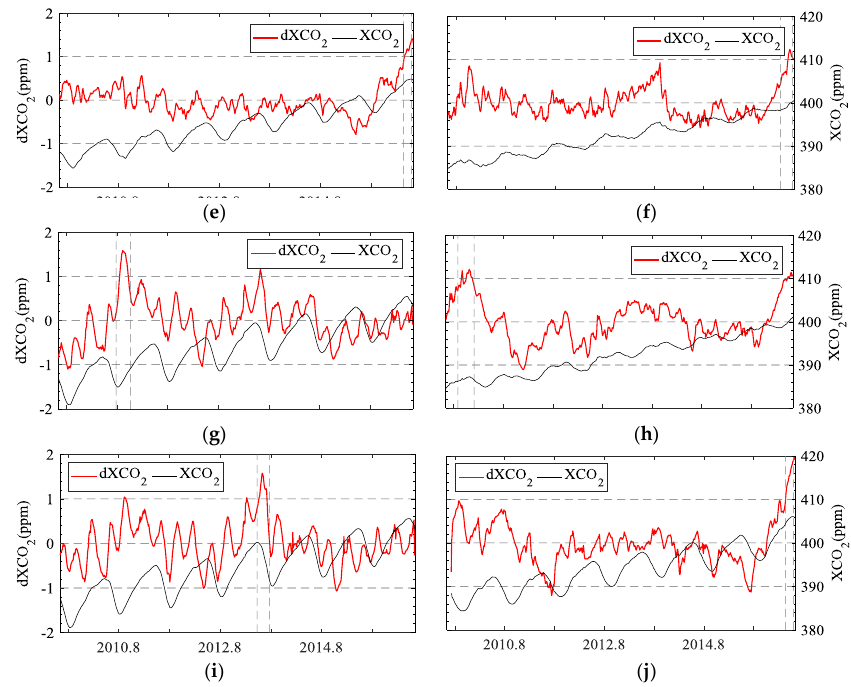
Figure 3. Temporal change of spatial mean dXCO 2 (red line) and XCO 2 (black line) over the covered area, with influenced time more than 15 days, for the ten largest events from June 2009 to May 2016. Extreme high XCO 2 is characterized with dXCO 2 . The duration of the extreme events are highlighted with dashed vertical lines. ( a ) Ex-1: Forest and Cropland; ( b ) Ex-2: Sparse Shrub-land; ( c ) Ex-3: Savanna and Shrub-land; ( d ) Ex-4: Savanna; ( e ) Ex-5: Bare land; ( f ) Ex-6: Grassland and Shrub-land; ( g ) Ex-7: Forest; ( h ) Ex-8: Shrub-land and Savanna; ( i ) Ex-9: Forest and Shrub-land; ( j ) Ex-10: Forest and cropland.